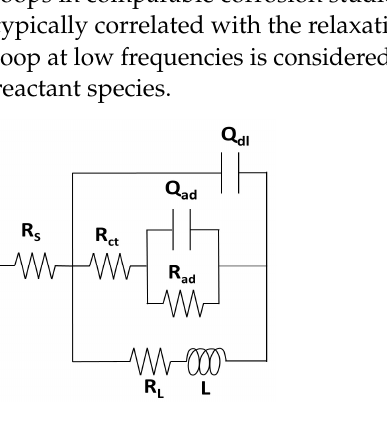
Figure 6. Equivalent circuit used for the impedance-fitting procedure.